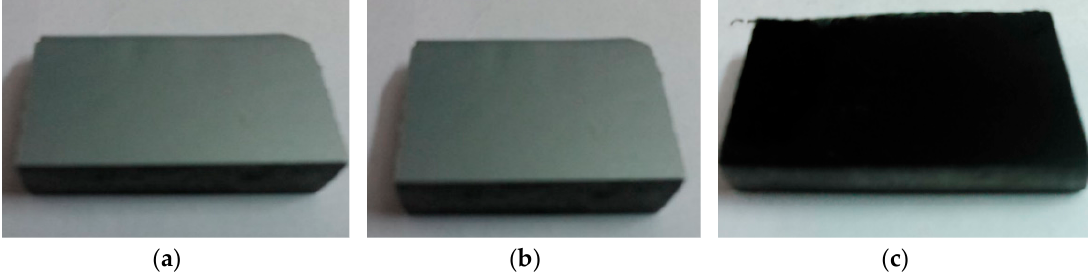
Figure 5. ( a ) Acrylic paint ED coat; ( b ) 2-coat polyester without primer; ( c ) 3-coat polyester with epoxy primer—coating thickness measurement.